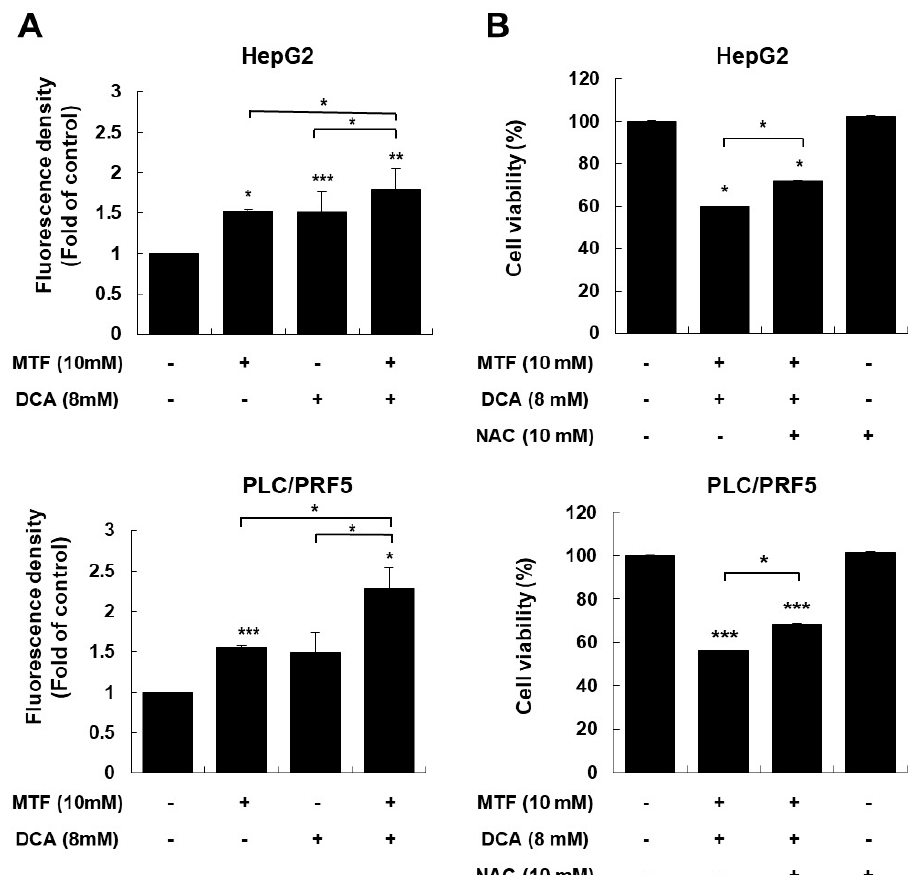
Figure 5. Co-treatment with metformin and DCA increased oxidative stress in HepG2 and PLC/PRF5 cells. Liver cancer cells were treated with metformin, DCA, or both for 1 h. ( A ) Co-treatment with metformin and DCA significantly increased reactive oxygen species (ROS) production in liver cancer cells compared to the control. ( B ) Treatment with the antioxidant N-acetylcysteine (NAC) (10 mM) significantly decreased the cytotoxic effects of the metformin and DCA co-treatment in liver cancer cells. * p < 0.05; ** p < 0.01; and *** p < 0.001.